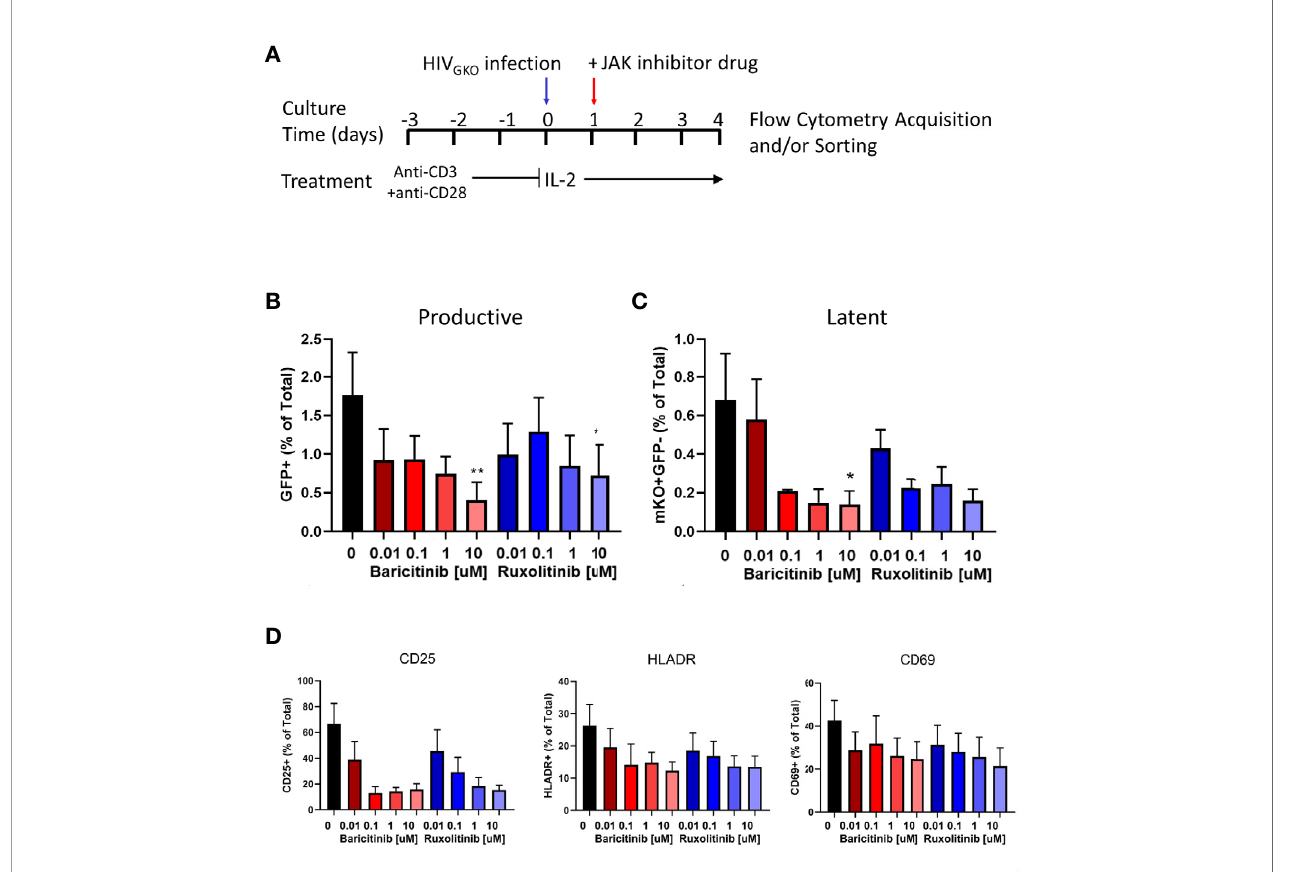
FIGURE 5 | Effect of JAK1/2 inhibitors on productive and latent infection. (A) Schematic showing experimental design for activation and infection with HIV GKO of puri fi ed tonsillar CD4 + T cells. Bar graphs showing average frequency of (B) GFP + (productive) cells and (C) mKO+GFP- (latent) cells on day 4 post-infection in presence of JAK1/2 inhibitors at different concentrations. Error bars represent standard error of the mean (SEM), students t test was used to compare all conditions against the no drug control (black bar), *p < 0.05, **p < 0.01. (D) Bar graphs showing average frequency of cells expressing activation markers on day 4 post- infection in presence of JAK1/2 inhibitors at different concentrations. Results shown represent 3 independent